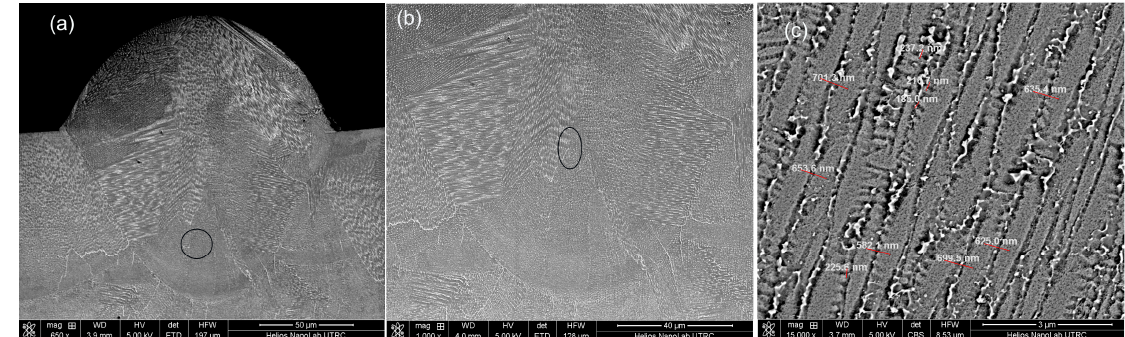
Figure 2. Scanning electron microscope (SEM) image of ( a ) transverse cross section of sample deposited at 285 W and 0.96 m/s, ( b ) region of analysis for PDAS and SDAS and ( c ) sample measurements for